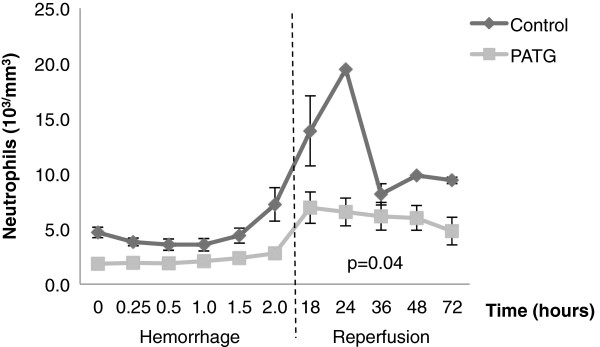
Peripheral neutrophil counts during hemorrhage and reperfusion periods. One-way ANOVA with repeated measures design was used for statistical comparison. Error bars represent ± SEM.